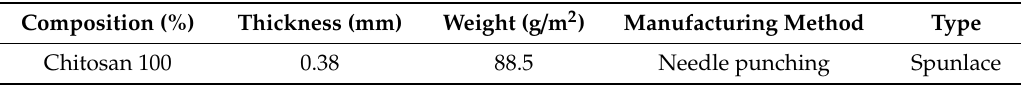
Table 1. Characteristics of chitosan nonwoven.